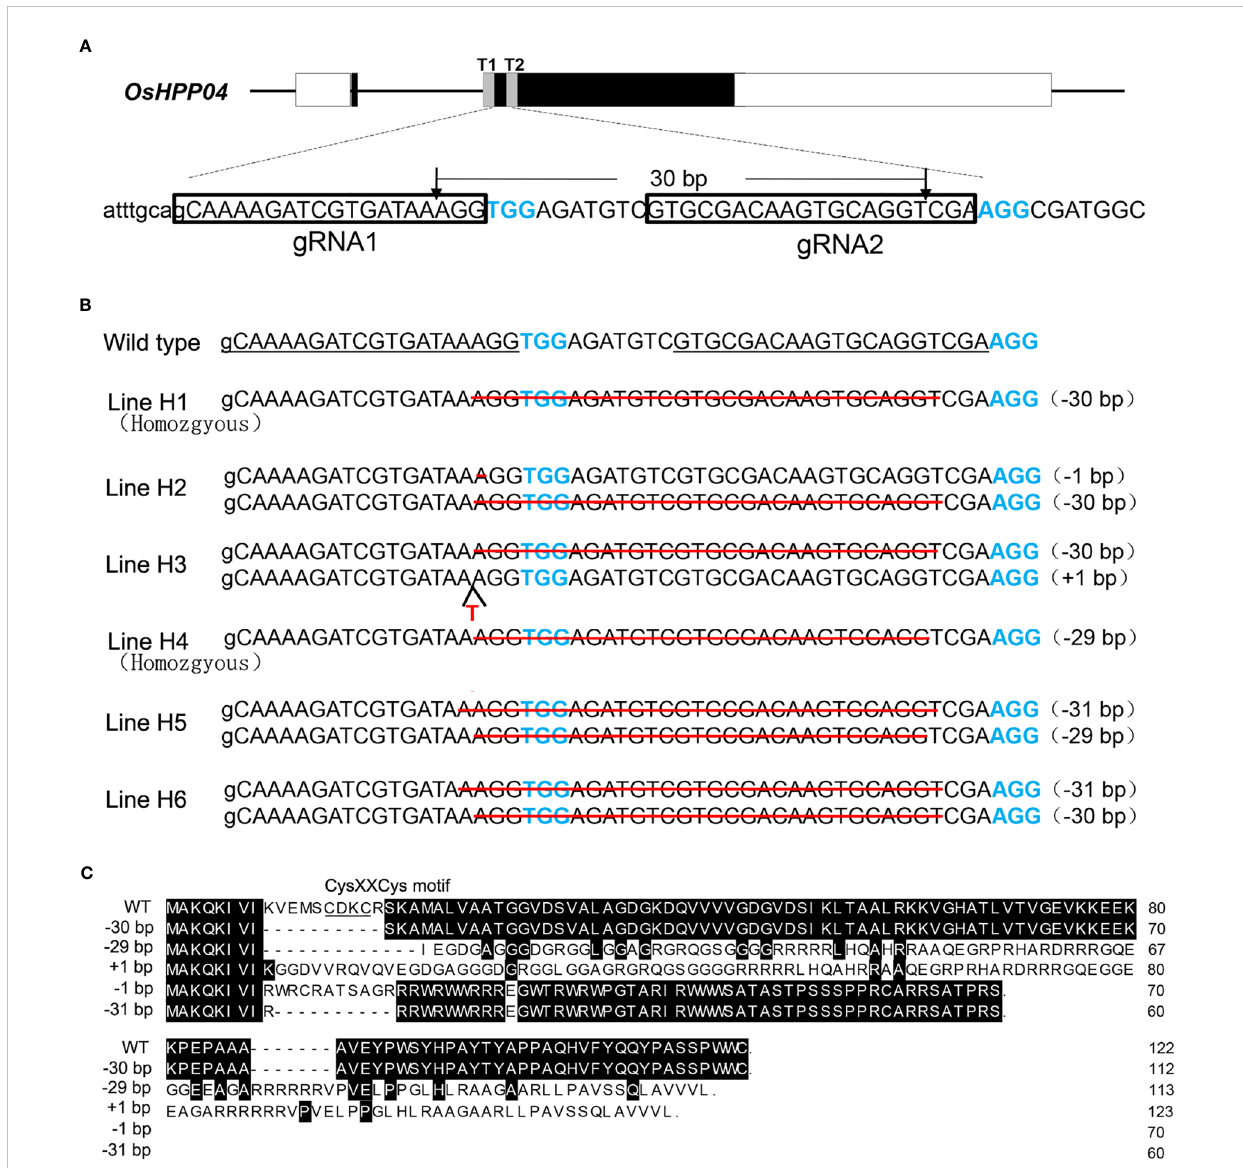
FIGURE 1 CRISPR/Cas9-targeted mutagenesis of OsHPP04 in rice. (A) Target sites of CRISPR/Cas9. Two gRNAs (T1 and T2) were chosen in the second exon. Nucleotides in blue represent protospacer adjacent motif (PAM) sequences. (B) The mutated sequences of OsHPP04 knockout rice lines. The number of base deletion and/or insertion is shown by the mark of minus (-) and plus (+) followed by a number in brackets, respectively. (C) Alignments of deduced OsHPP04 amino acid sequence from OsHPP04 knockout rice lines and wild-type rice (WT). Dots indicate the termination of